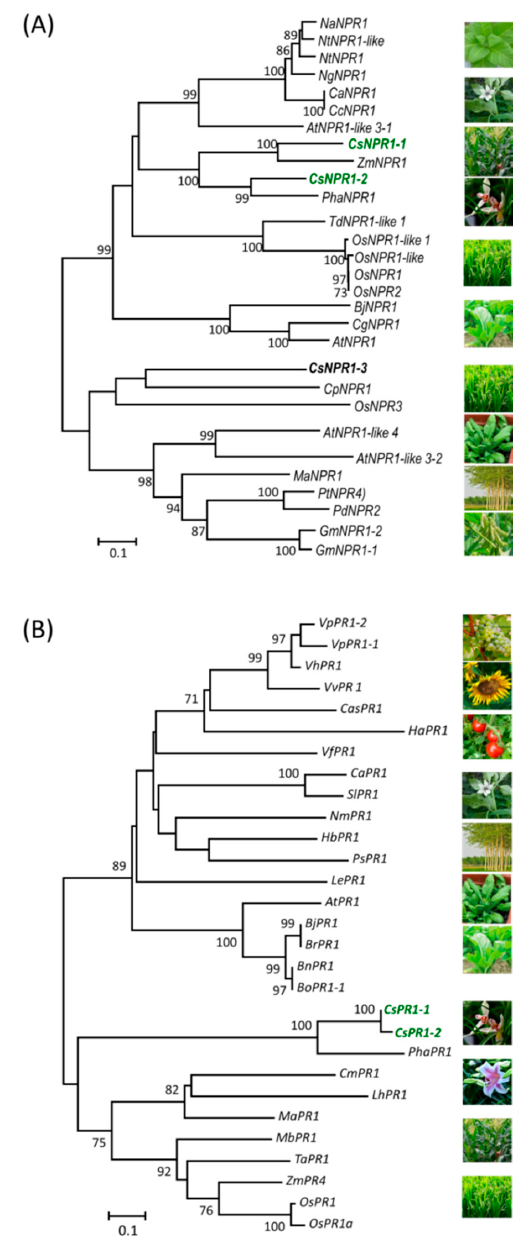
Figure 2. Phylogenetic analyses of CsNPR1 and CsPR1 genes and their homologous in various plant species. The deduced amino acid sequences of ( A ) NPR1 and ( B ) PR1 homologs from di ff erent plant species were used to construct the phylogenetic trees using the neighbor-joining method with the 1000 bootstrap values indicated. The information for the homologs used in the analysis is listed in Tables S1 and S2.